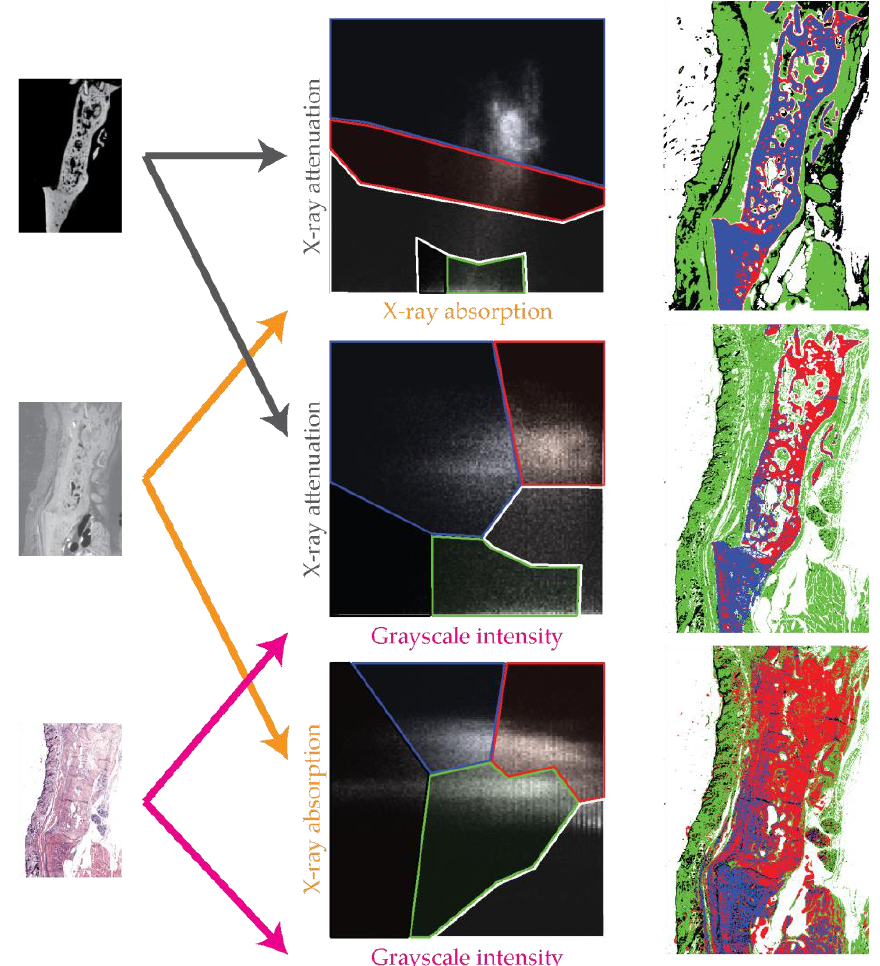
Figure 10. Corresponding data for the common area from the selected slices of two of the three modalities can be displayed as 2D histograms. Analysis of these bivariate histograms applying k- means clustering enabled segmentation. The segmented anatomical features within the slices are colored to elucidate the structural similarities between the pair-wise combination of the three se- lected modalities, see images in the third